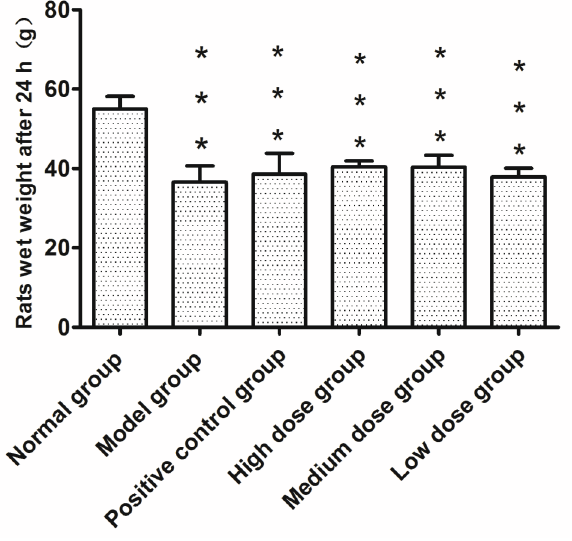
Figure 3: The body weight of rats for 24 Fig. 3 The body weight of rats for 24 h